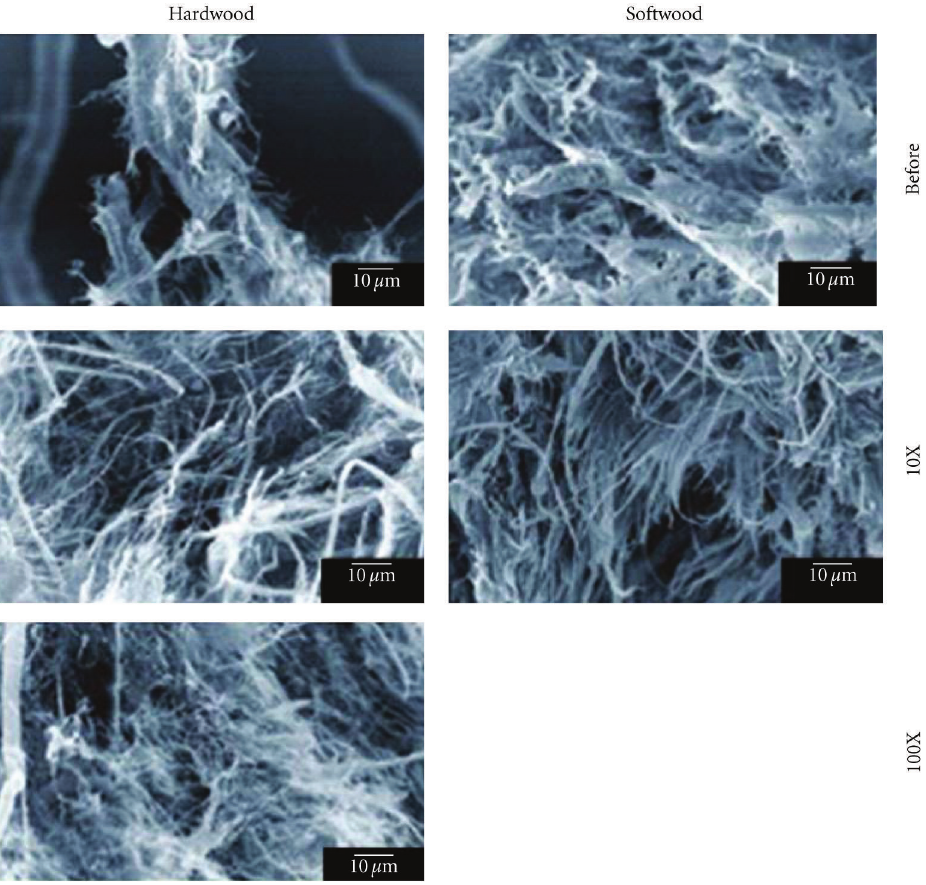
Figure 3: Scanning electron micrographs of hard- and softwood cellulose fibers, before and after 10 passes through the homogenizer [35].